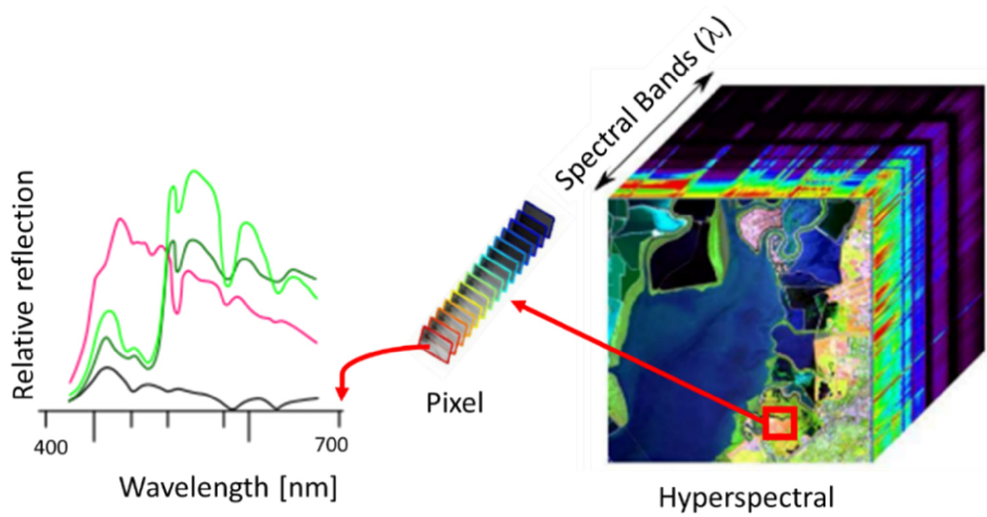
Figure 8. Example of a hyperspectral image, where each pixel consists of a complete reflection spectrum at its position.